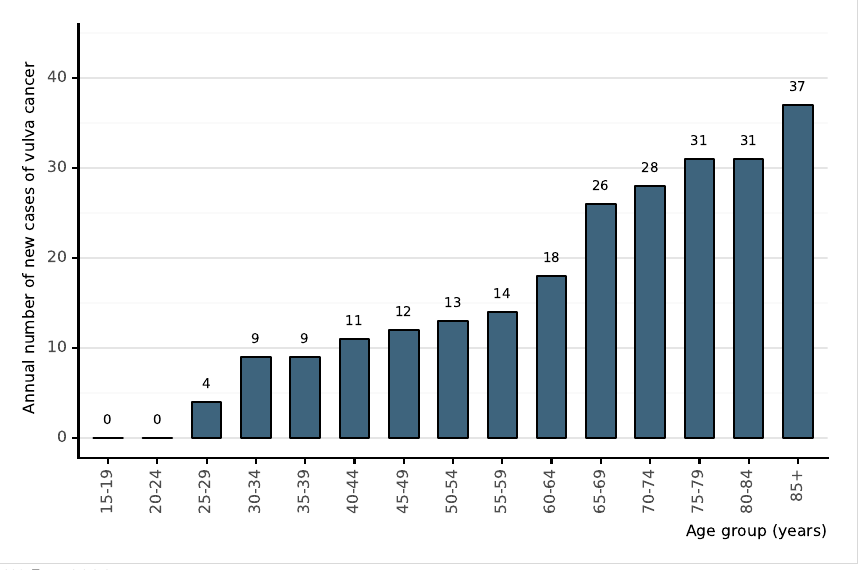
Figure 22: Annual number of new cases of vulva cancer in Peru (estimates for